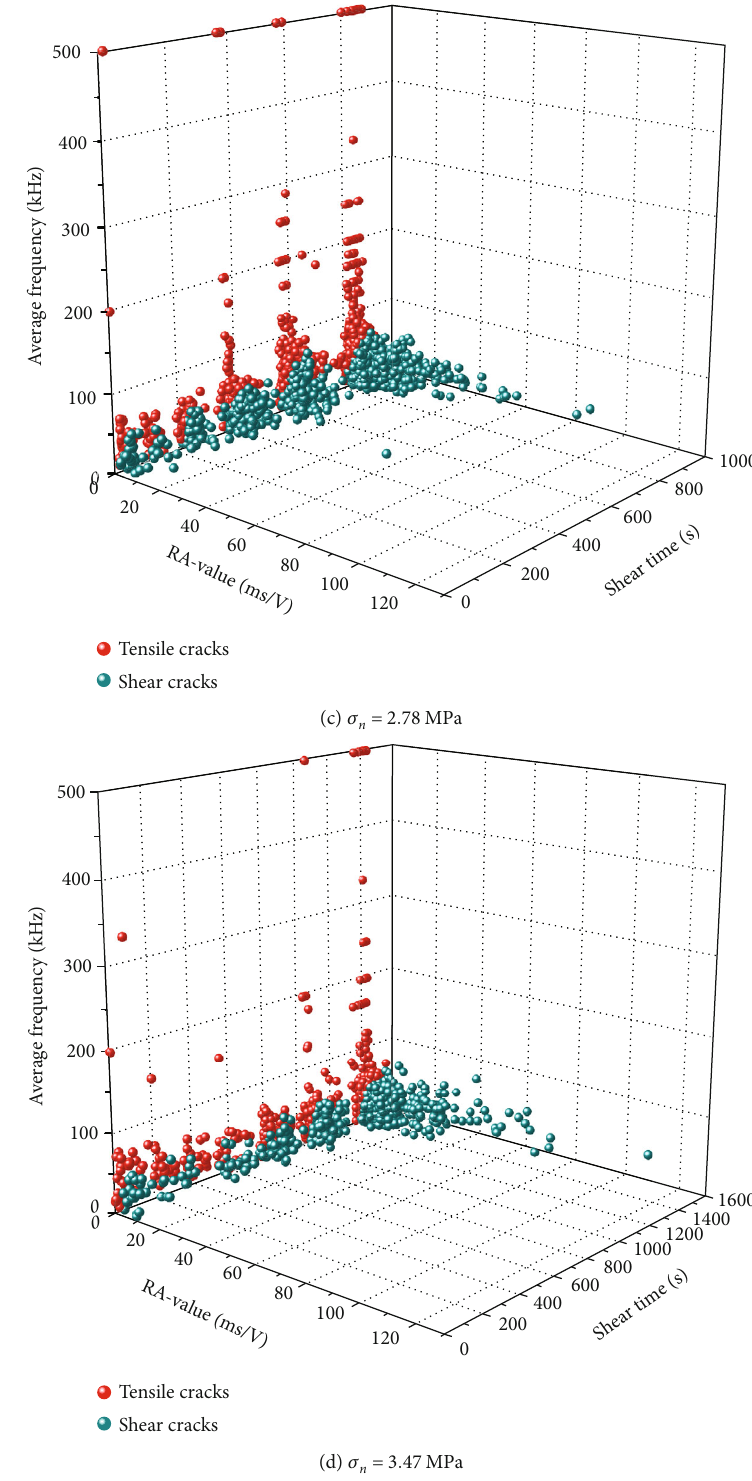
Figure 10: Signal evolution of the tensile cracks and shear cracks at di ff erent normal stress In the cyclic shearing process under four normal stresses, the acoustic emission signal of skarn joints has three signal characteristics. (1) For di ff erent normal stress shear tests, the tensile signal is dominant during the fi rst cycle shearing,